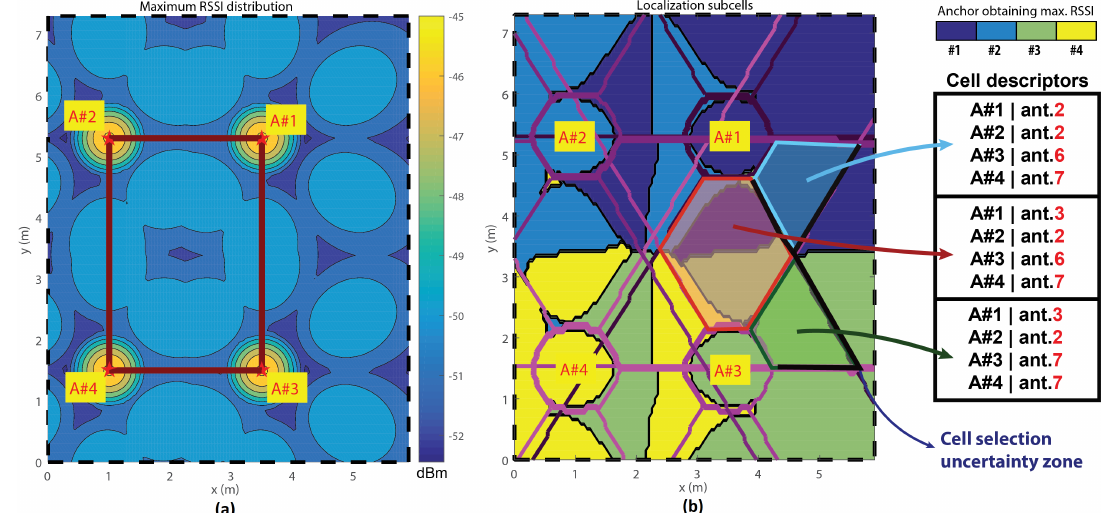
Figure 7. Maximum RSSI distribution over the site ( a ) and related cell descriptors ( b